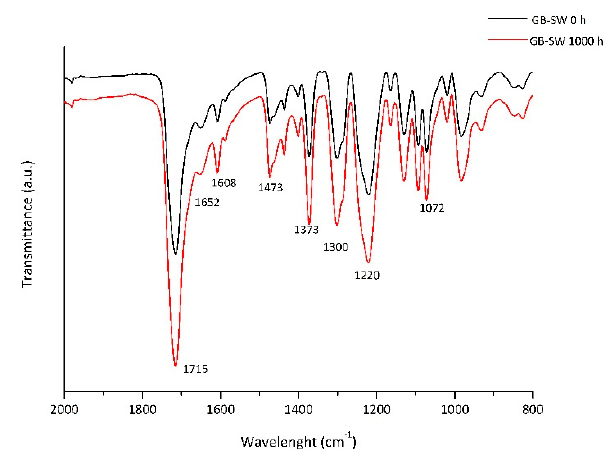
Figure 6. FT-IR spectra of the GB-SW sample before and after 1000 h of UVA exposure.